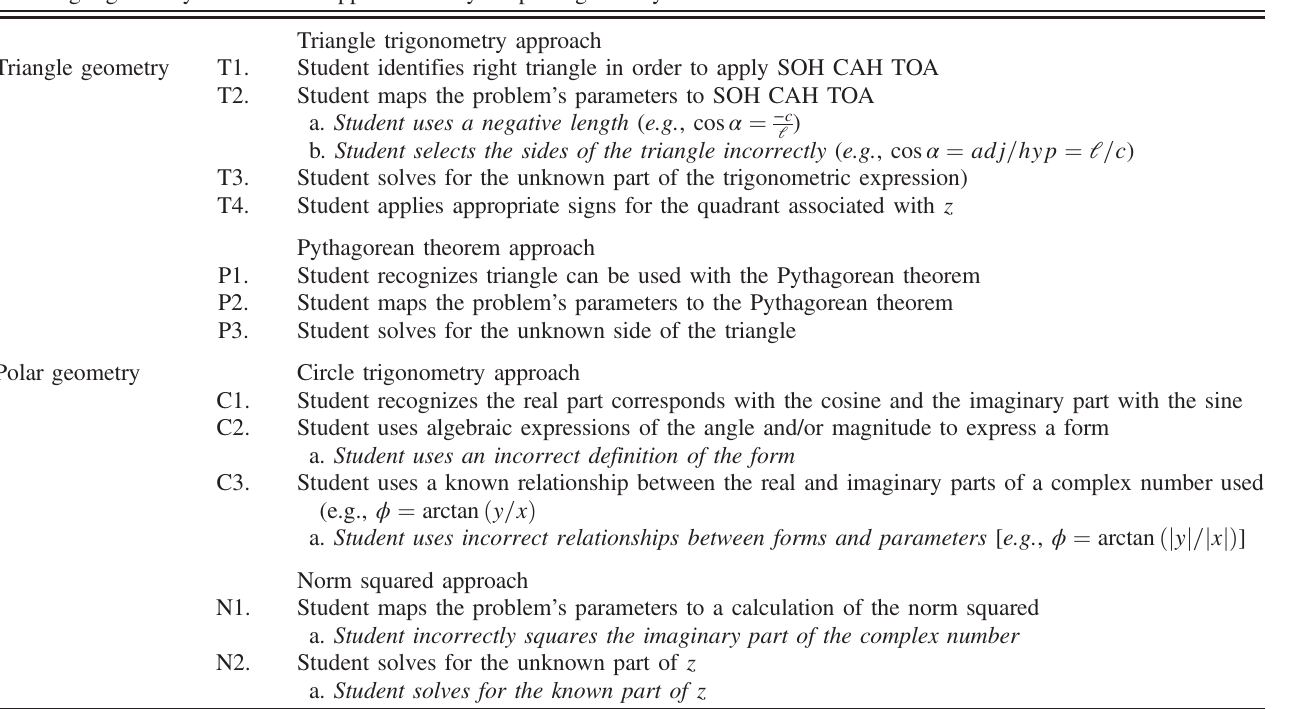
TABLE III. Summary of codes describing approaches. Italicized codes are specific errors in executing a step. The top approaches rely on triangle geometry. The bottom approaches rely on polar geometry.